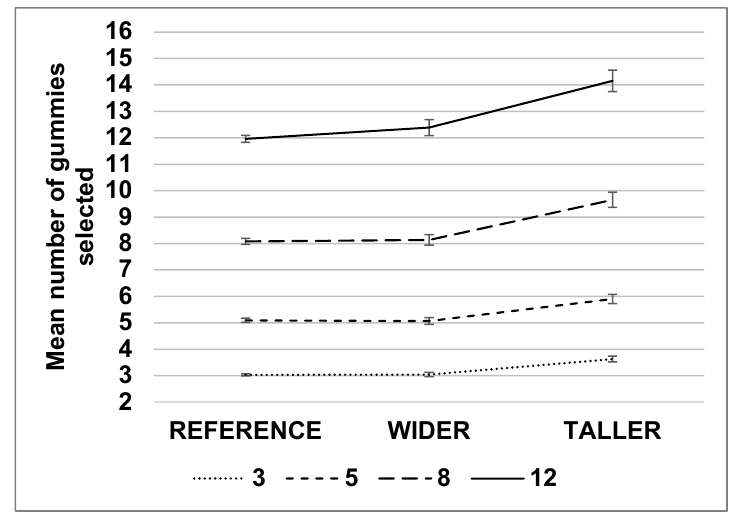
Figure 4. Mean number of gummy candies selected ± SEM for each number of gummy candies presented (3, 5, 8, 12) and shape of candy (REFERENCE, WIDER, TALLER).